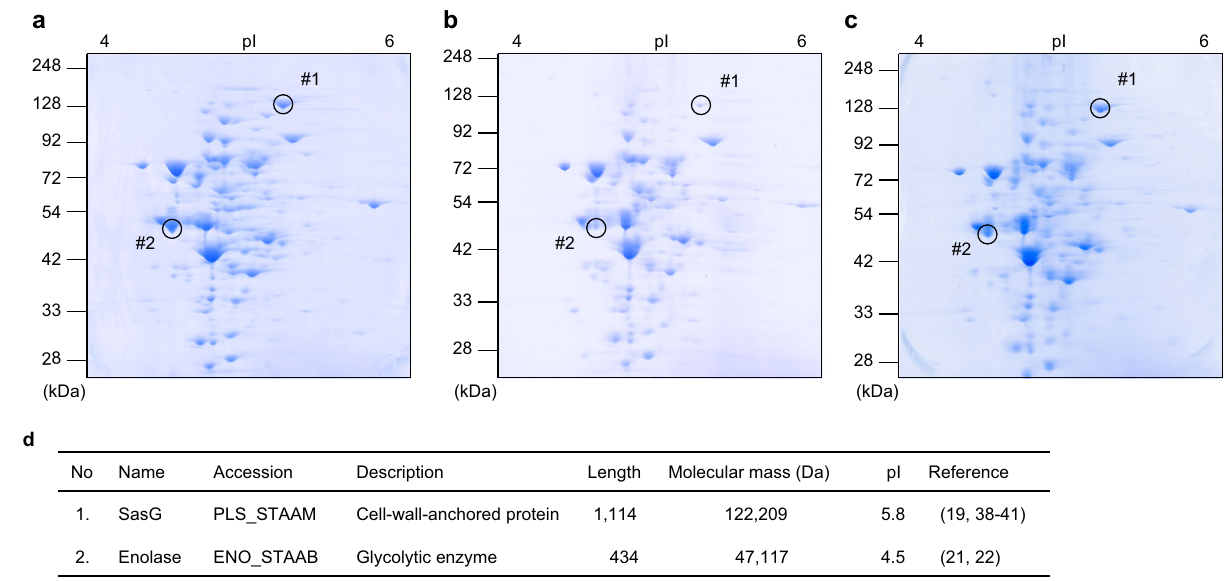
Fig. 2 The effects of NGM on the proteome of S. aureus . a – c Two-dimensional (2-D) electrophoresis in the presence or absence of NGM or 17DN ( a DMSO control; b NGM; c 17DN). d Identi fi cation of proteins, whose expressions were decreased in the presence of NGM on 2-D gel a b DN t. M on G 17 C N